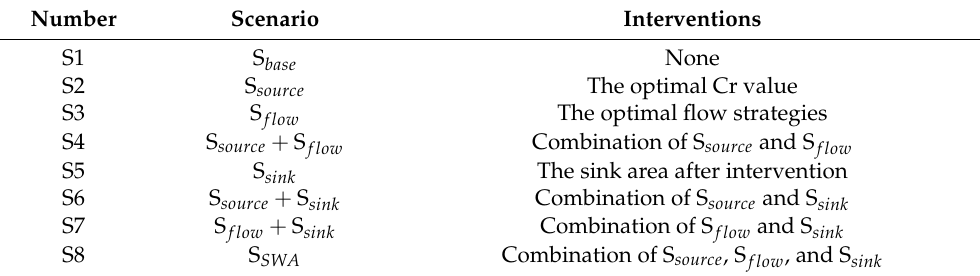
Table 1. Details of the eight intervention scenarios modeled in this